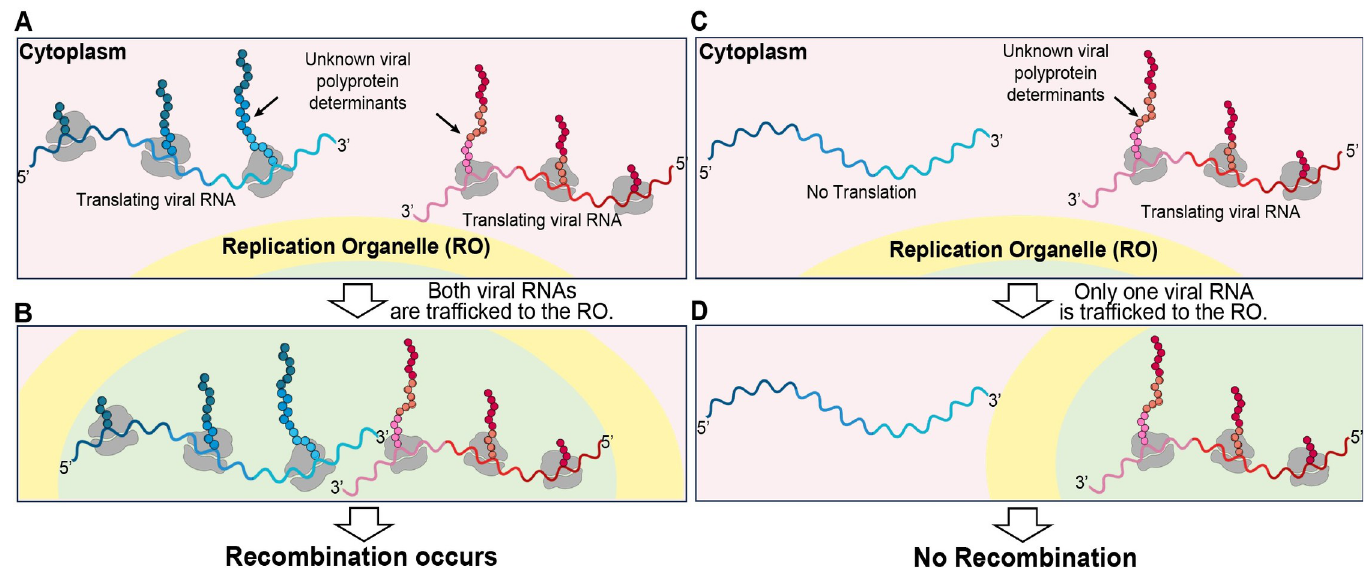
Fig 1. Hypothesis: Polyprotein determinants presented during translation direct the enteroviral genome to the site of replication. For recombination to occur between two genetically distinct PV genomes, these genomes must be in the same replication organelle. (A, B) Viral RNAs, shown in blue and red, are targeted to the replication organelle while being translated and facilitate RNA recombination between the two colocalized genomes. Specific viral polyprotein determinants, indicated by a black arrow, mediate this trafficking while still a part of the polyprotein and in association with the ribosome. (C, D) In a case where one genome with impaired polyprotein synthesis, shown in red, is also infected by a second genome, shown in blue, the genome with impaired polyprotein synthesis cannot be trafficked to the replication organelle, so recombination between the two genomes cannot occur. This figure was created by Efraı´n E. Rivera-Serrano using BioRender. PV AU : Pleasenotethat } WT } hasbeenfullyspelledoutas } wild (cid:0) type } atfirstmentioninthesentence } Indeed ; theactivityintheabsenceofafunctionalIRES ::: } Pleasecorrectifnecessary : , poliovirus; RO, replication